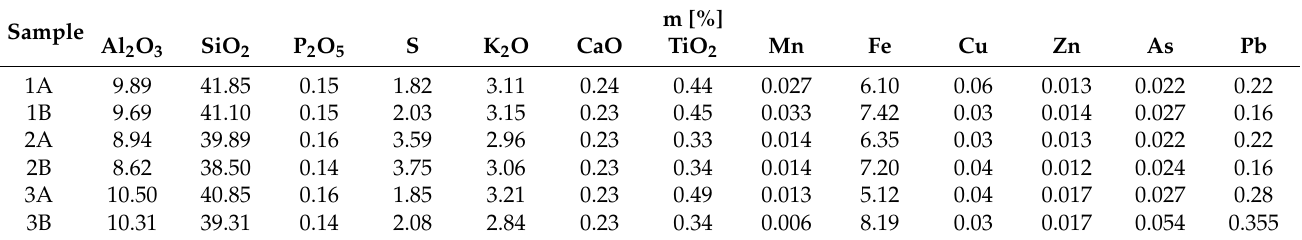
Table 2. Chemical compositions of samples from the Ilba sterile mining deposit, based on p − XRF